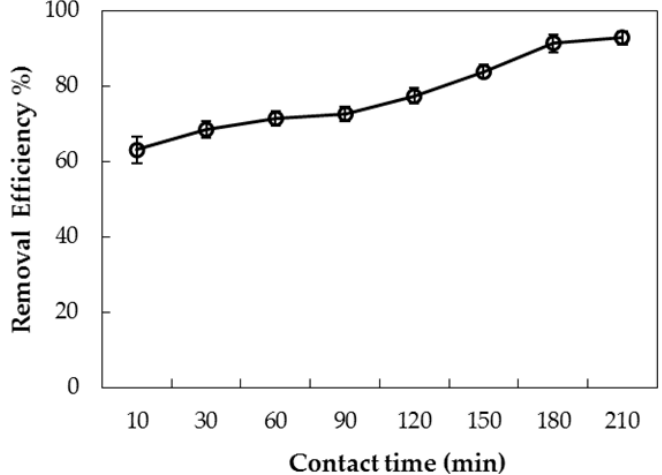
Figure 12. Influence of contact time on removal of amoxicillin (AMX) using PDADMAC-modified silica (PMS). Error bars show standard deviations of three replicates.